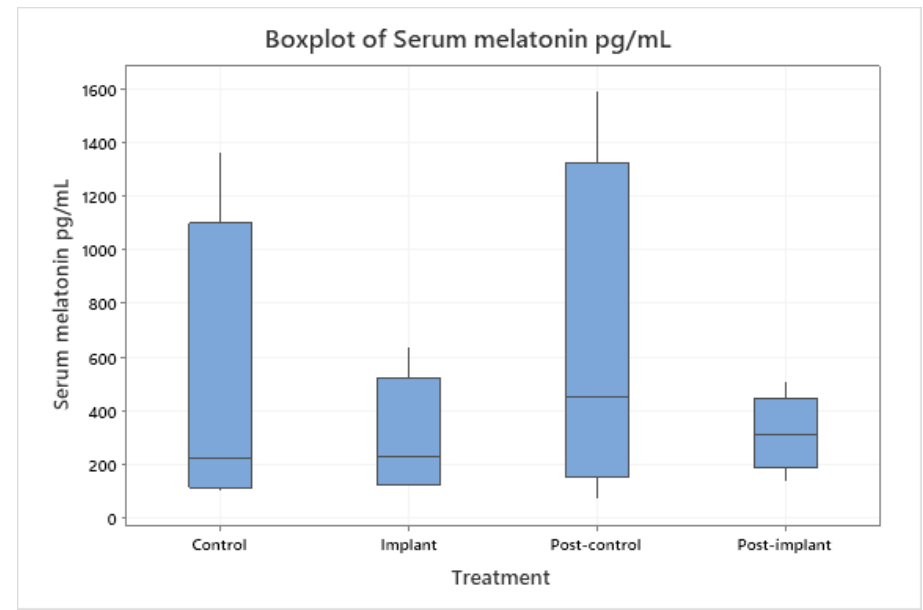
Figure 1. Boxplot of serum melatonin in the control (n = 4) and the treatment (n = 5) groups. Control/Implant refers to samples collected on the day of implant or sham implant. Post-control/Post-implant refers to blood samples collected at one time-point 8–30 days after the Control/Implant samples. There were no significant differences between the groups ( p > 0.05).